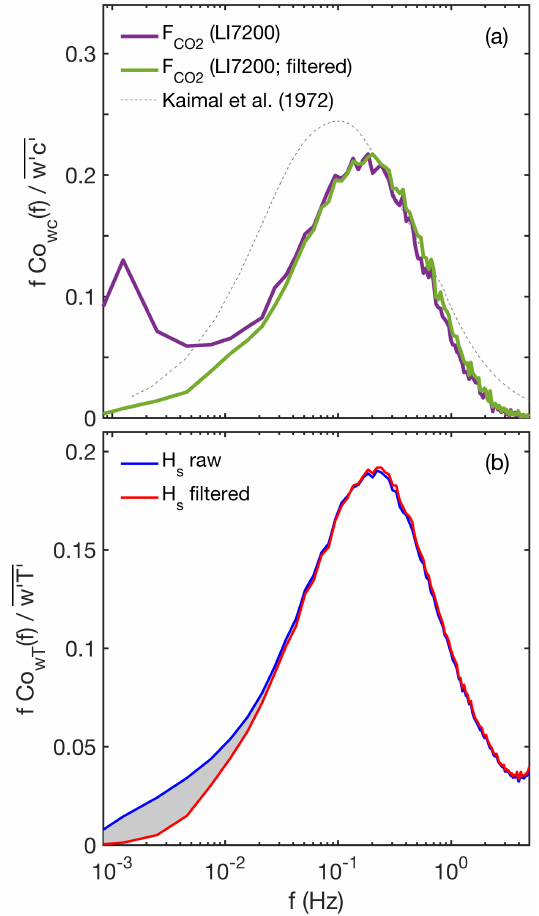
Figure 5. Median normalized frequency-weighted cospectra for F CO (a) and H S (b) . In (a) the purple line represents the cospec- 2 trum calculated from the uncorrected LI-7200 CO 2 mixing ratio. The green curve represents the cospectrum calculated from the high-pass-filtered LI-7200 CO 2 mixing ratio. The dashed gray line represents the theoretical scalar cospectra from Kaimal et al. (1972). In (b) the blue curve represents the cospectrum for H S calculated from an unfiltered air temperature measurement. The red curve represents the cospectrum for H S calculated from air temperature passed through the same high-pass filter applied to the CO 2 mixing ratio in the F CO calculation (i.e., first-order Butterworth filter with 2 0.005Hz cutoff). The area below the shaded region between the two curves represents the median loss of real low-frequency flux due to